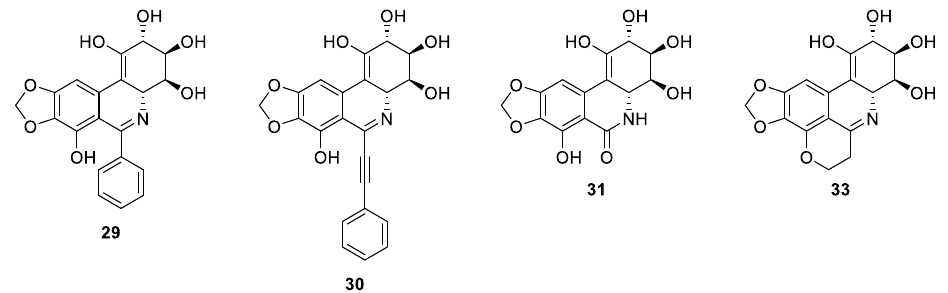
Figure 4. Structures of biologically evaluated C-1/C-6 narciclasine analogues.